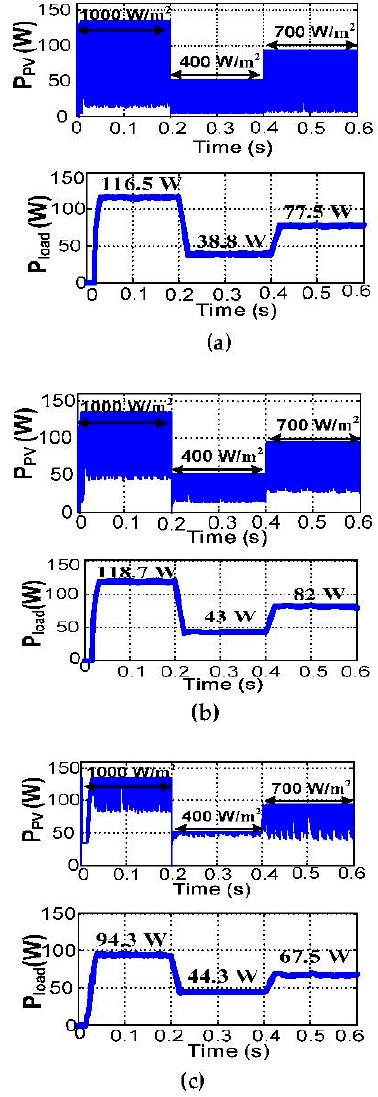
Figure 4. CUK PV power and average load power for: ( a ) 0.5 mH; ( b ) 1 mH; ( c ) 5 mH.